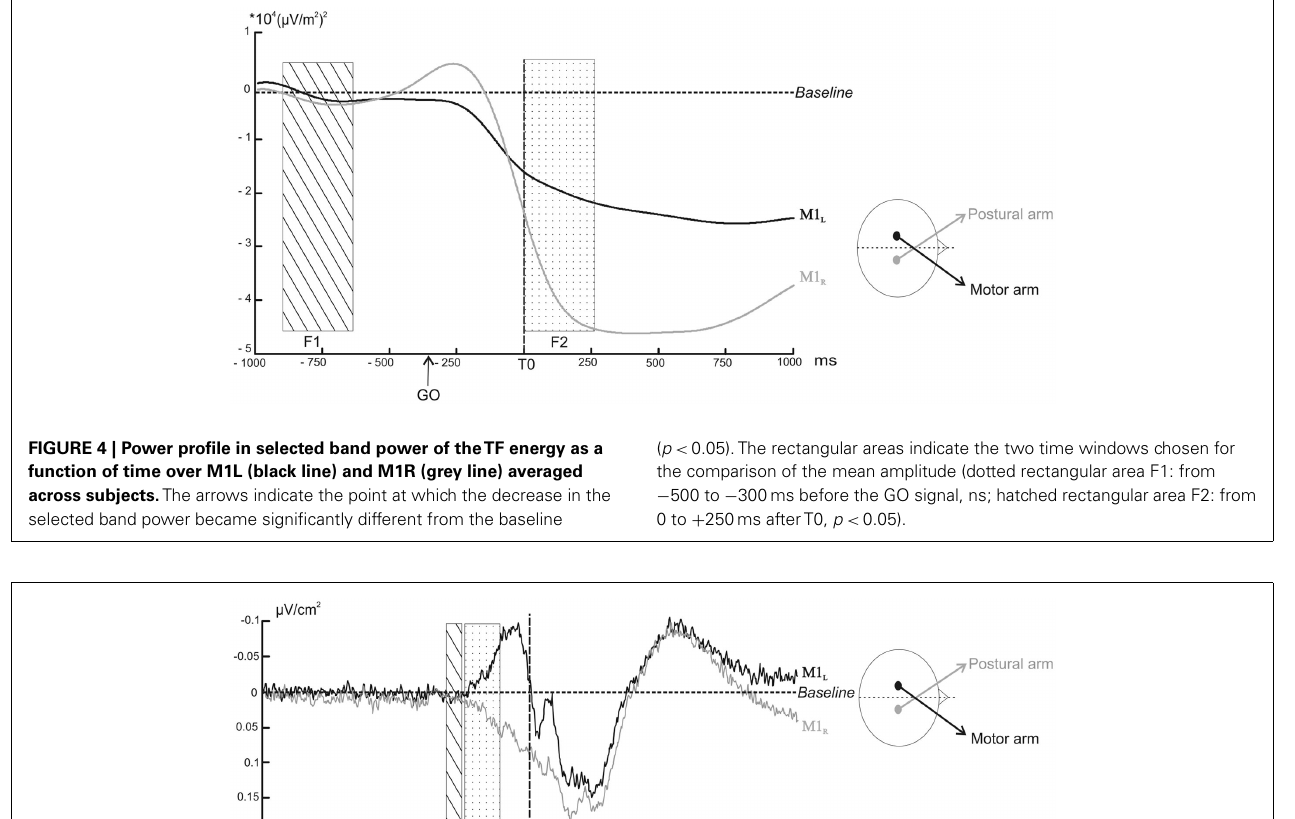
for the comparison of the slope to a theoretical zero value (dotted rectangular area P1: from − 300 to − 250ms beforeT0, ns; hatched rectangular area P2: from − 240 to − 140ms beforeT0, p <